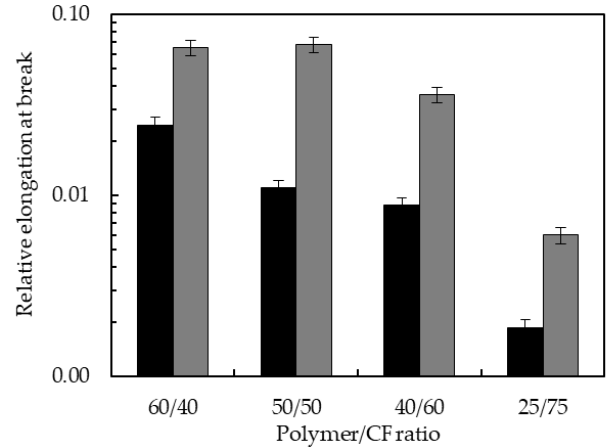
Figure 9. Relative elongation at break of TPUU-SS/CF (black) and TPUU/CF (gray) biocomposites.